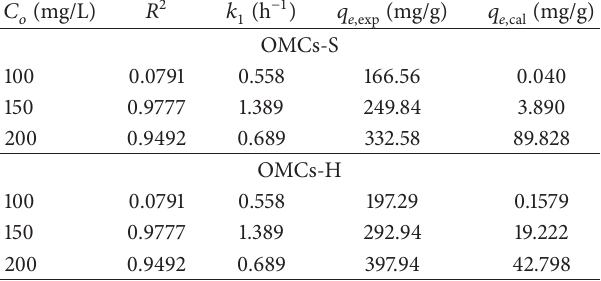
Table 5: Rate adsorption constants and MB adsorption capacities calculated according to pseudo-first-order equation of OMCs-S and